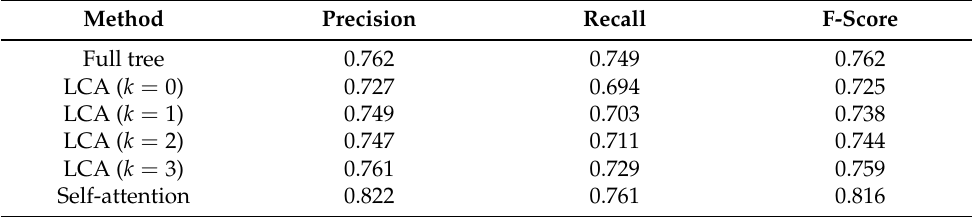
Table 5. Ablation study on different syntactic dependency extraction